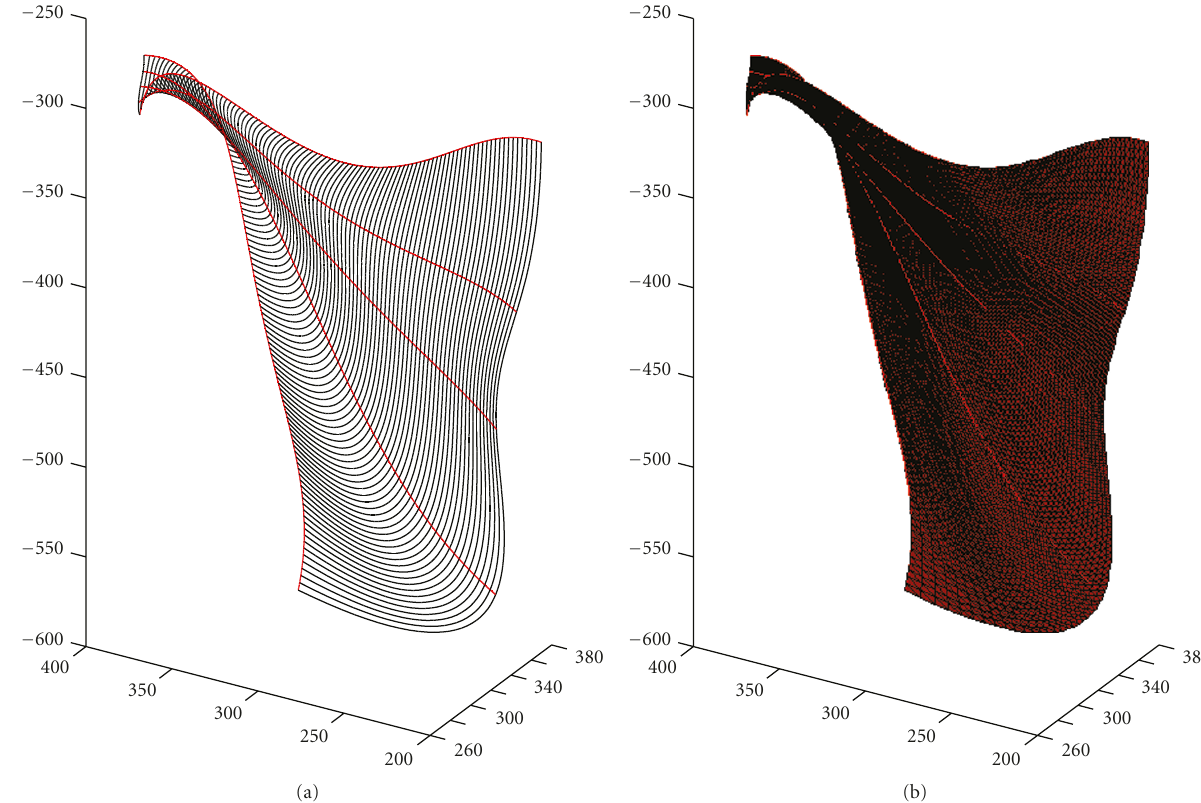
Figure 2: Muscle surfaces are reconstructed by cubic spline interpolation of n equidistant point on the fitted t-polynomials. The given example represents the latissimus dorsi muscle.